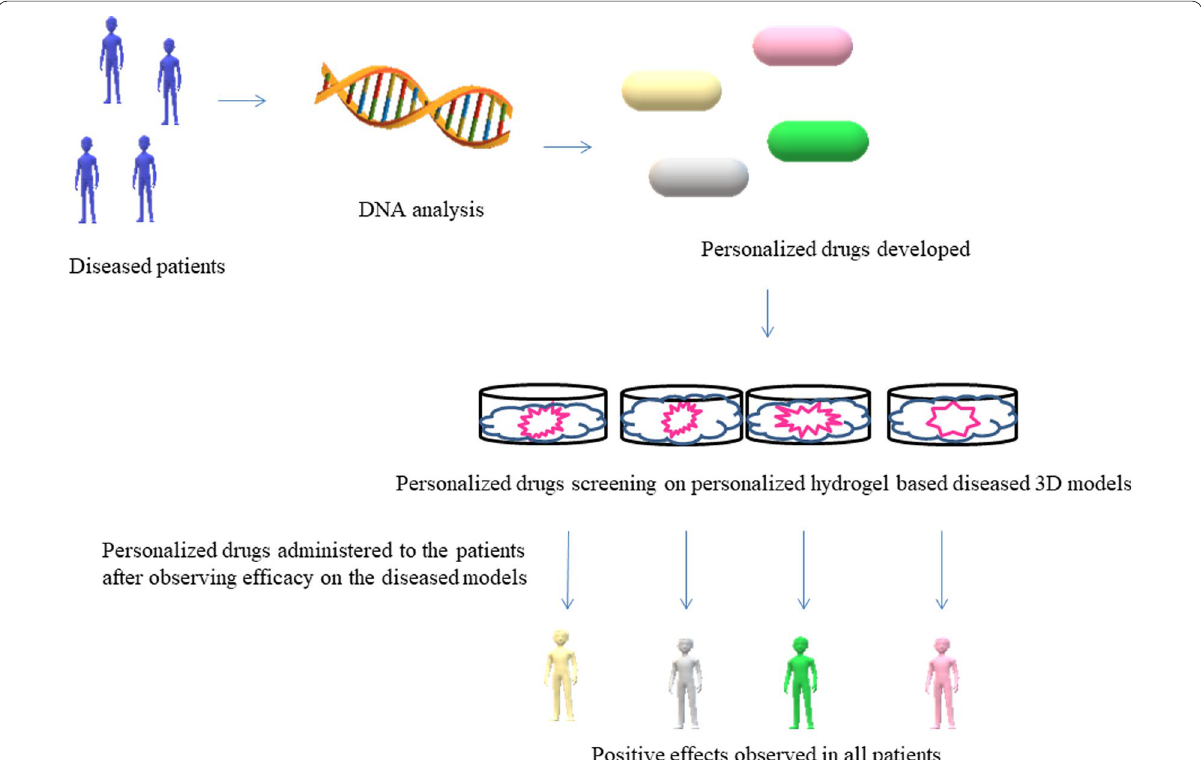
Fig. 5 Drug screening on in vitro hydrogel-based diseased 3D micro models can provide accurate data about the efficacy of the personalized drugs